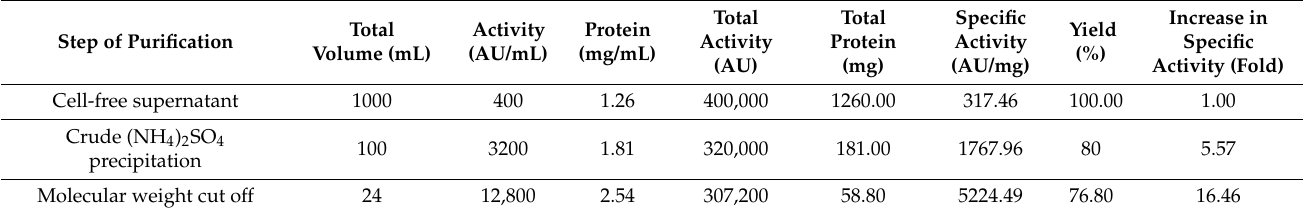
Table 3. Purification steps of AMPs produced by E. faecium OV3-6.